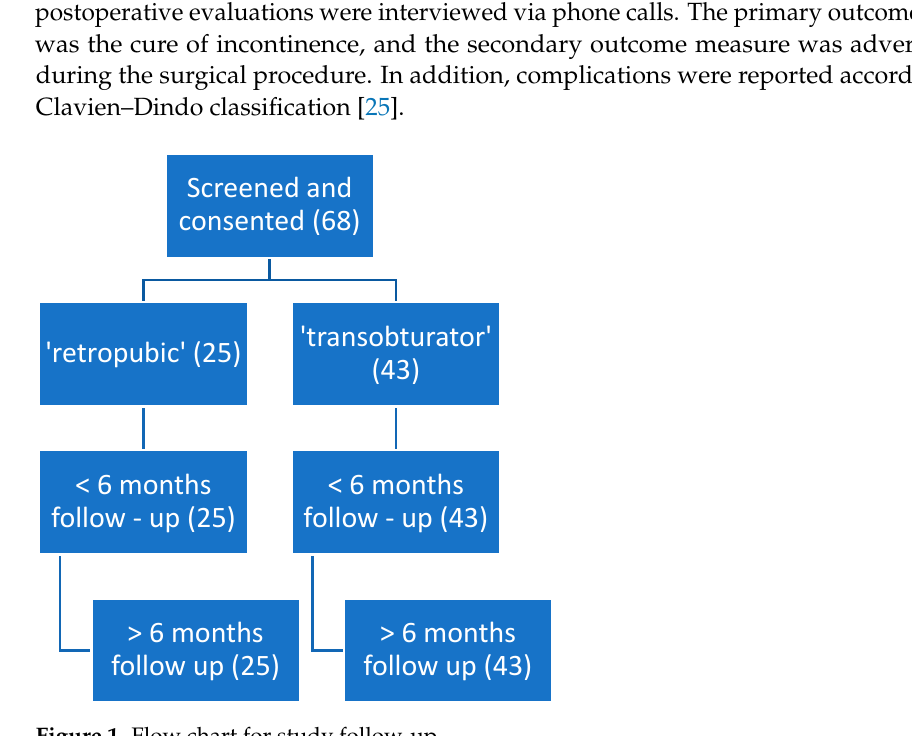
Figure 1. Flow chart for study follow-up.